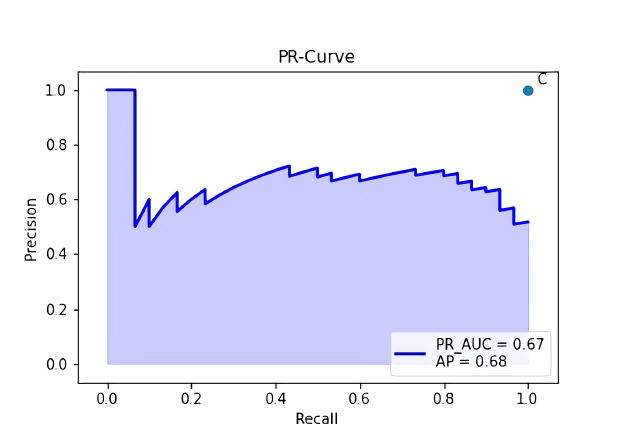
Figure 7. An example of PR